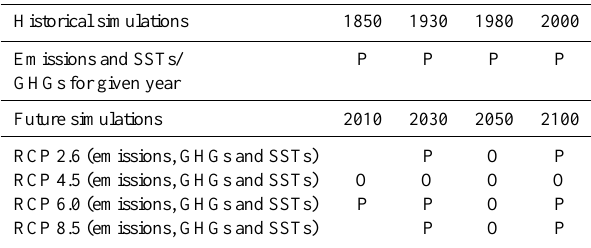
Table 1. List and principal characteristics of ACCMIP simulations (P indicates the primary simulations, O the optional ones). SSTs stands for sea surface temperatures and GHGs for greenhouse gases. Adapted from Lamarque et al.